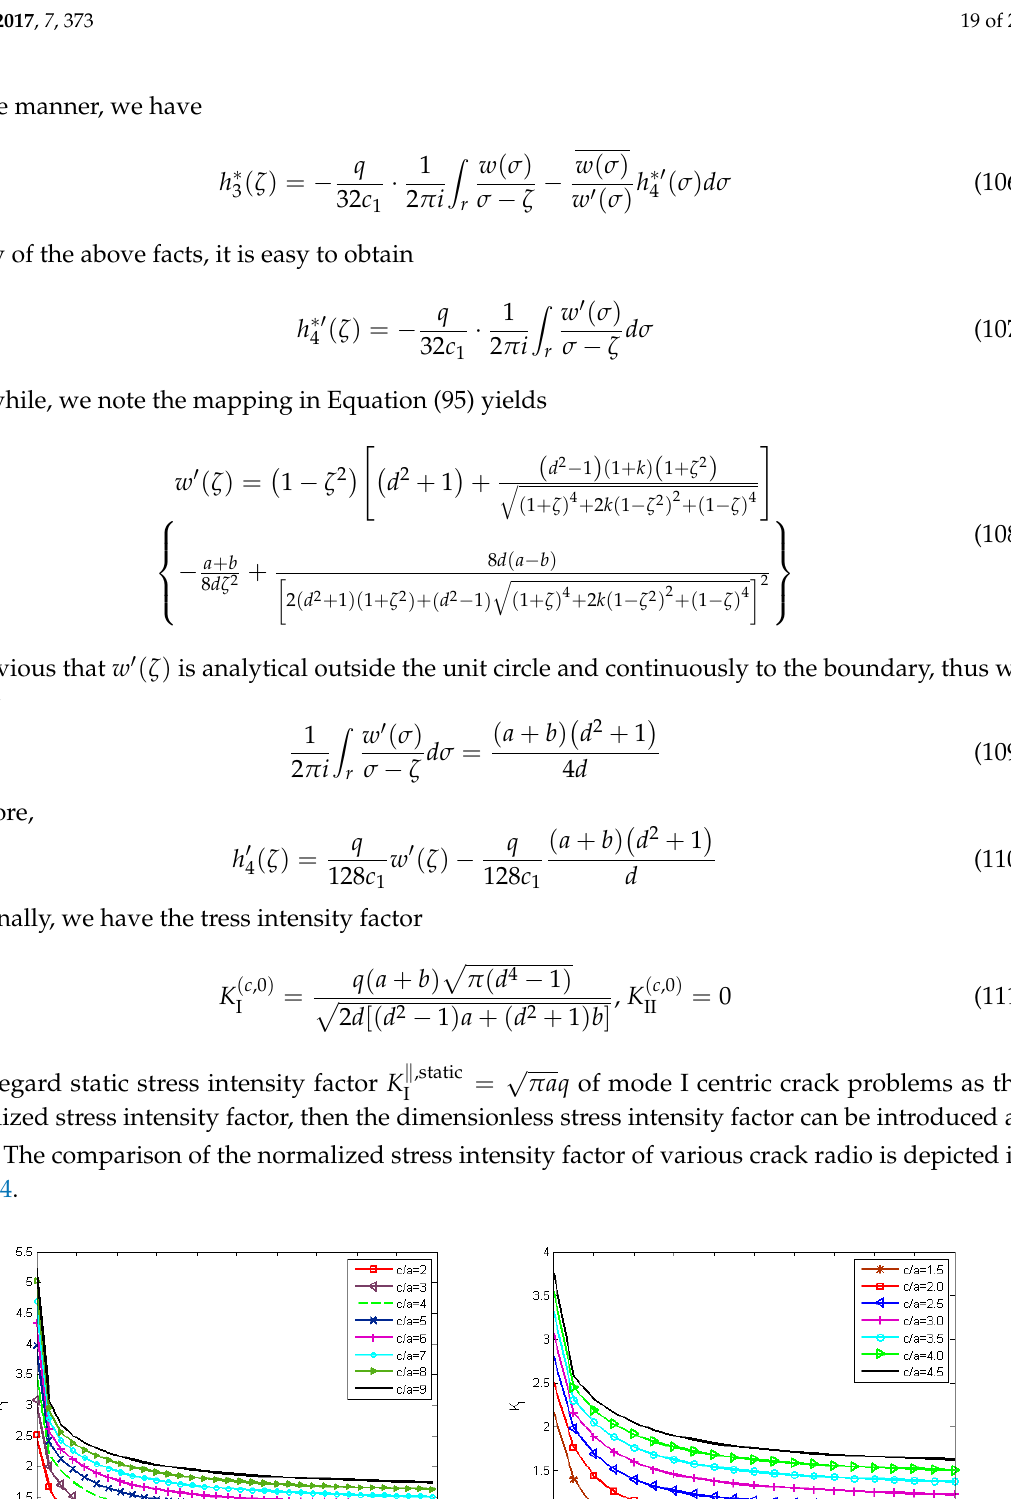
Figure 4. Variation and comparison of normalized stress intensity factor with crack radio c